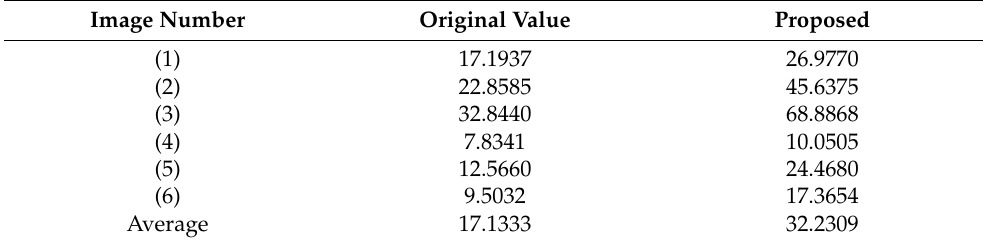
Table 3. DV-BV calculation